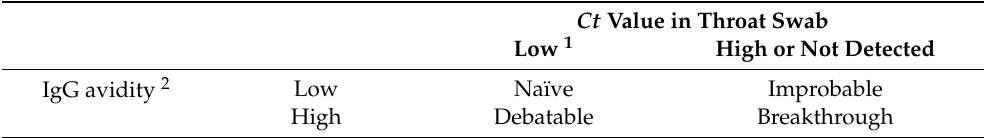
Table 2. Classification of the naïve and breakthrough measles cases in specimens at the initial symptomatic stage